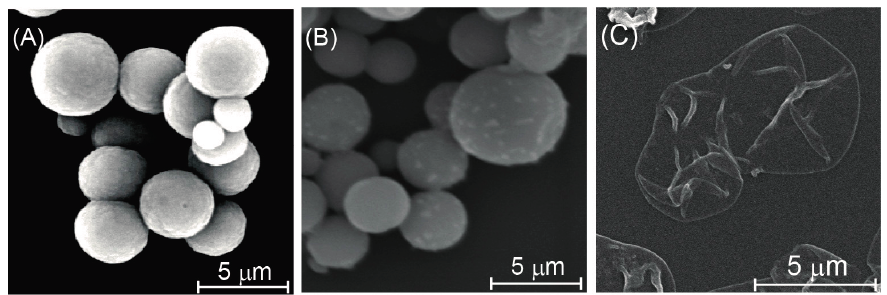
Figure 3. SEM images of CaCO 3 particles containing insulin and PSS ( A ), (PAH-PSS) 5 film-coated CaCO 3 particles ( B ); and dried (PAH/PSS) 5 microcapsules ( C ).